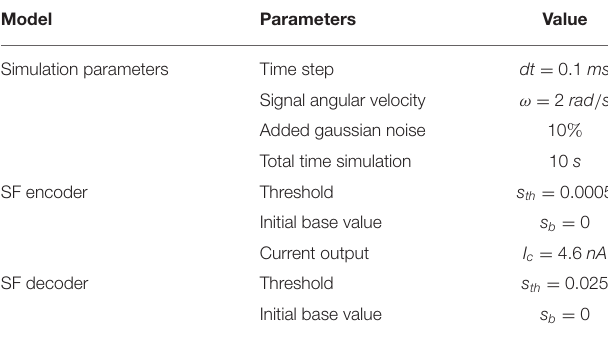
TABLE 3 | Modified Step Foward + STDP Encoding